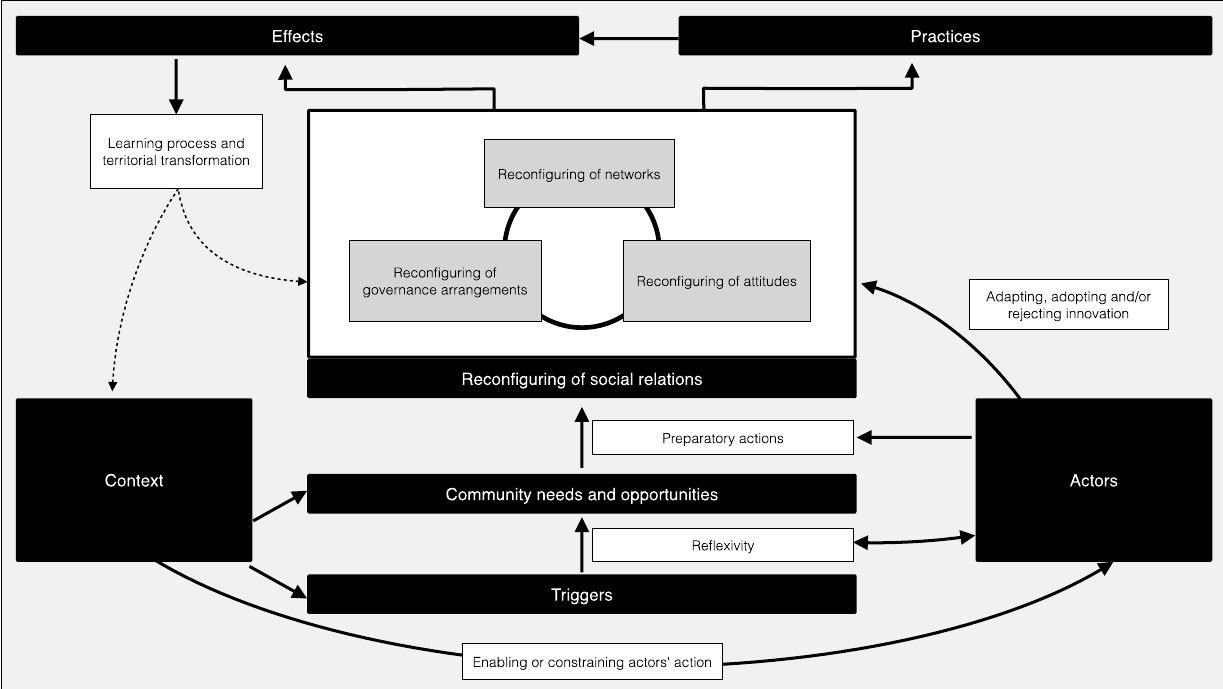
Figure 1. Territorial social innovation (TerriSI) conceptual framework. Own elaboration based on Neumeier [40], Secco et al. [47], Kluvankova et al. [67] and Vercher [68].